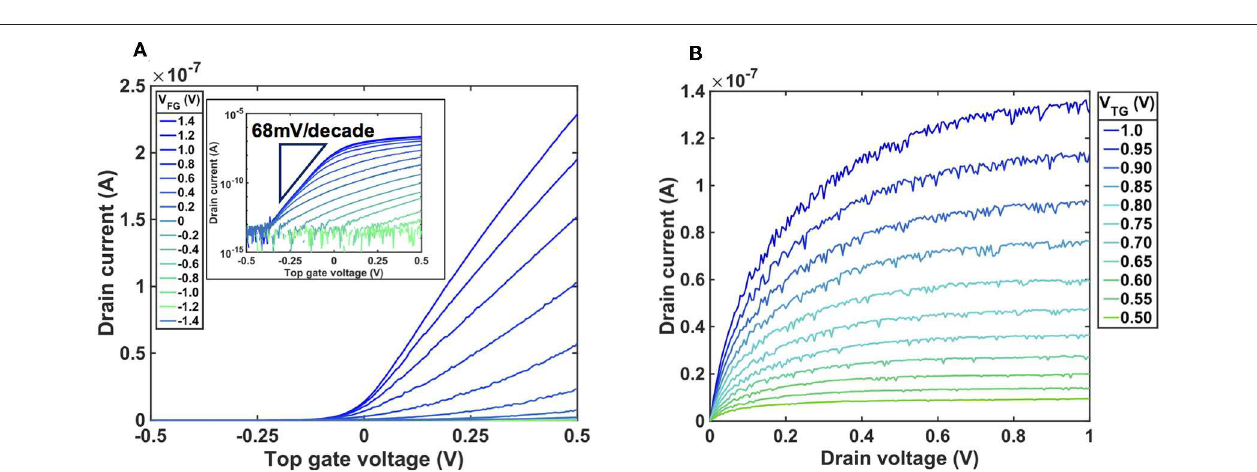
FIGURE 2 | Transistor characteristics of the silicon nanowire transistor. (A) The transfer characteristics of the device when V TG was swept from − 0.5 to 0.5 V, shown in linear scale. V FG was varied from 1.4 to − 1.4 V in 200 mV decrements. The inset shows the same characteristic in log scale. V D was 50 mV. (B) The output characteristics of the device when V D was swept from 0 to 1.0 V, while V FG was 0 V and V TG was varied from 0.5 to 1.0 V in 50 mV increments.